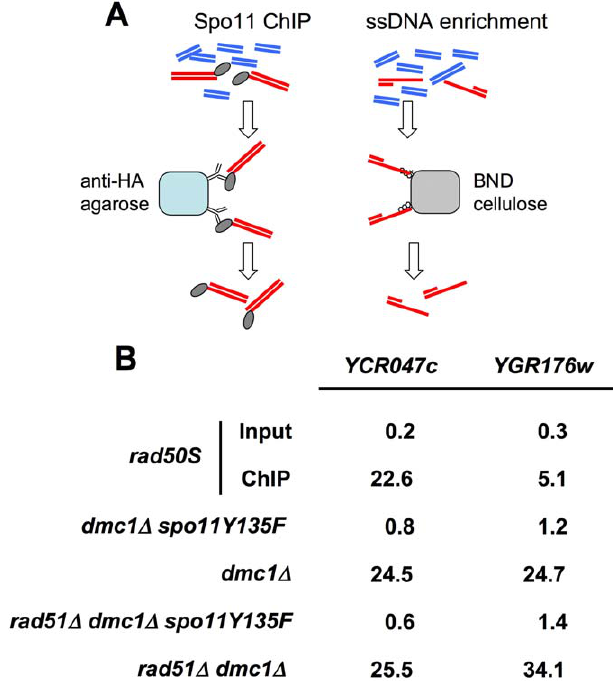
Figure 2. Enrichment of DSB-associated DNA (A) Cartoon illustrating enrichment procedures used (see Protocol S1 for details). DSB ends formed in rad50S can be enriched by immunopreci- pitation of Spo11 covalently linked to break ends (here with antibody directed against a C-terminal 3xHA tag). DSBs formed in dmc1 D and rad51 D dmc1 D can be enriched by BND cellulose purification of ssDNA ends. (B) Quantitative PCR measurement of enrichment relative to ribosomal DNA (rDNA) for sequences near DSB hot spots ( YCR047c and YGR176w ). Spo11 enrichment ratios for rad50S (MJL1083) were determined from input samples and immunoprecipitates (ChIP). ssDNA enrichment ratios for dmc1 D (MJL3095), spo11Y135F dmc1 D (MJL3096), rad51 D dmc1 D (MJL3272), and spo11Y135F rad51 D dmc1 D (MJL3274) were determined using BND cellulose eluates. DSB frequencies at YGR176w and YCR047c , as determined on Southern blots, are ; 10% of chromosomes (Figure 5 and unpublished data); thus, the overall selectivity for DSBs in both Spo11 ChIP and ssDNA enrichment is 200–300-fold above